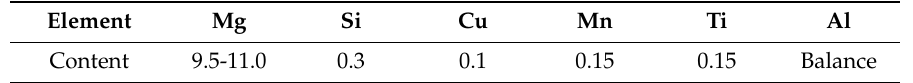
Table 1. Chemical composition of the Al-10Mg alloy (wt. %).